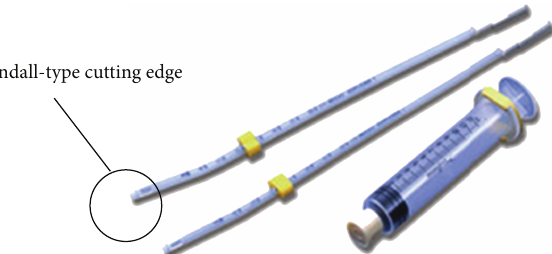
Figure 1: The Uterine Explora Model IMX120.